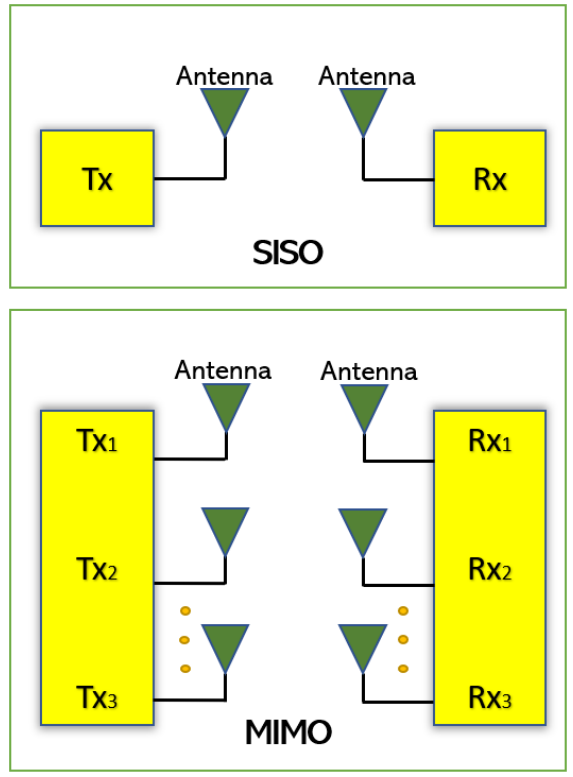
Figure 1. SISO and MIMO Antenna